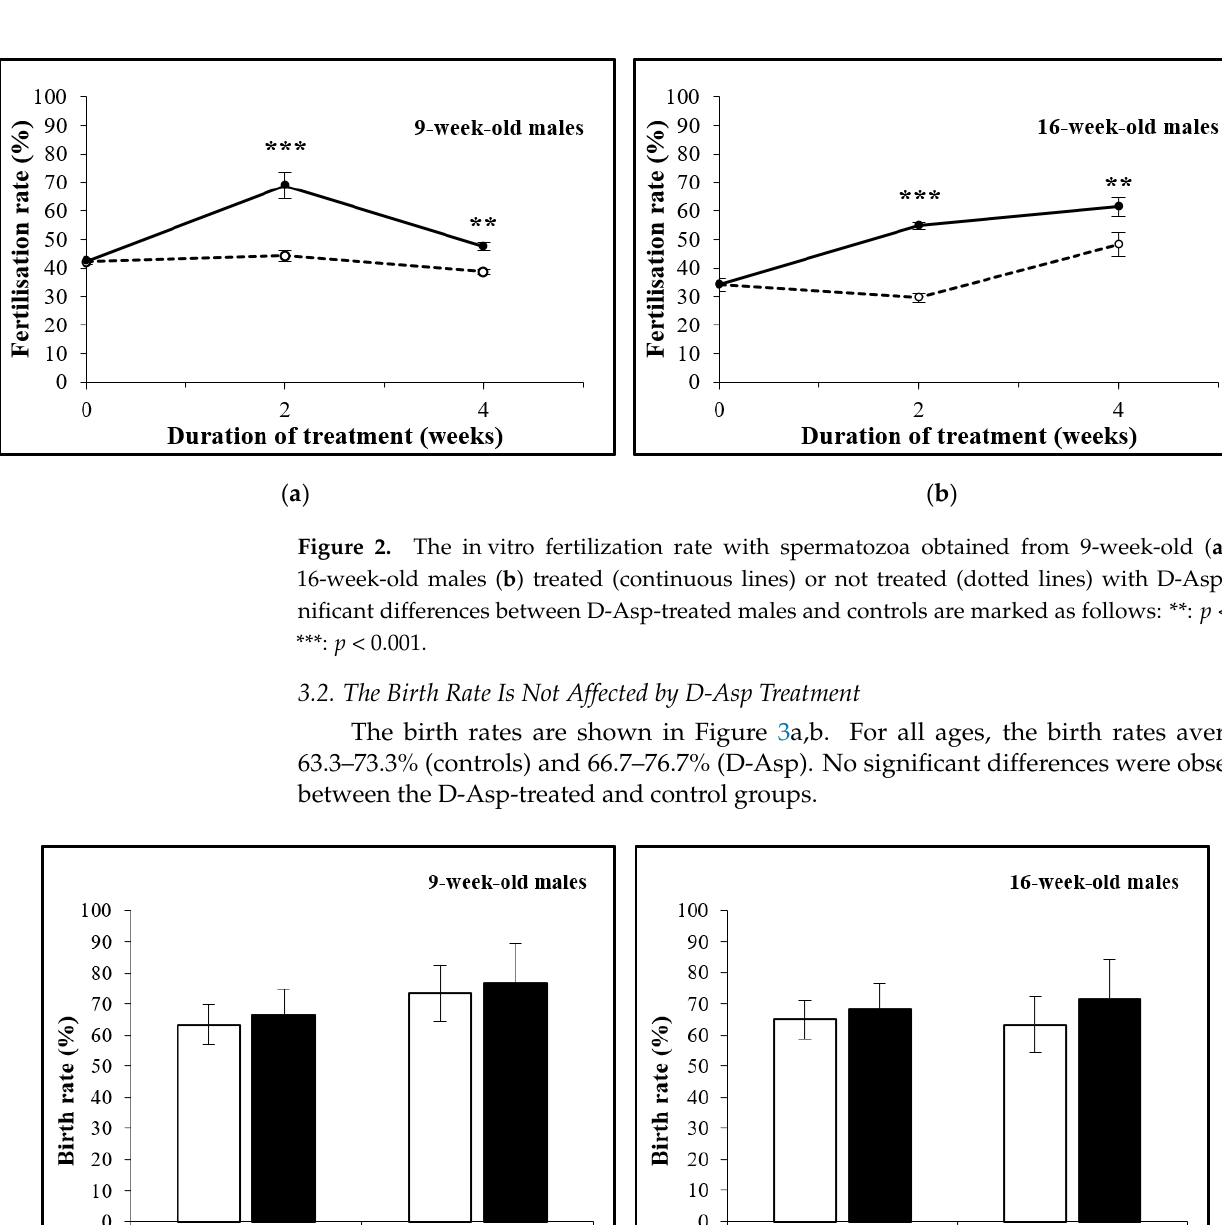
Figure 3. The birth rate with spermatozoa obtained from 9-week-old ( a ) and 16-week-old males ( b ) treated (black) or not treated (white) with